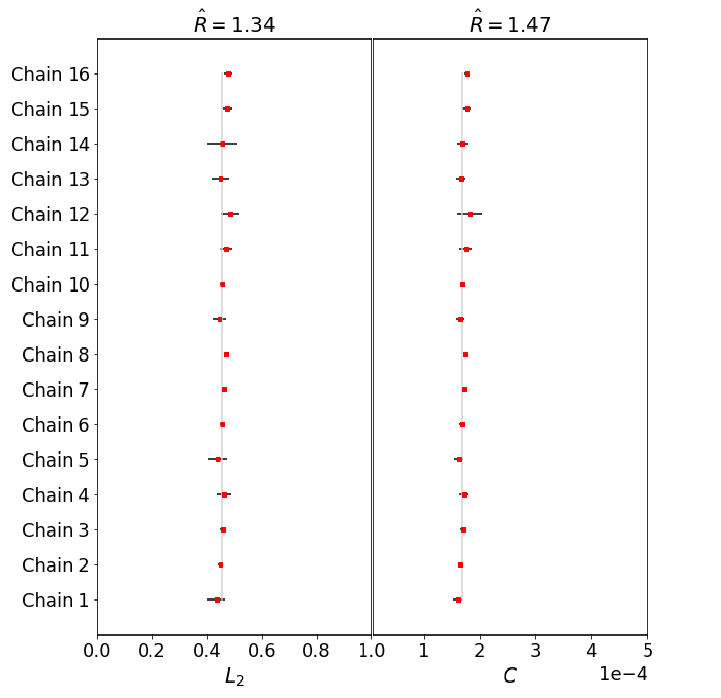
Figure 5. Gelman-Rubin test for Delta Gravity model assuming M V = − 19.23. The Gelman-Rubin test was run with 16 different chains, all with different L 2 and C priors. The ˆ R coefficient (Gelman-Rubin coefficient) was calculated for each parameter.